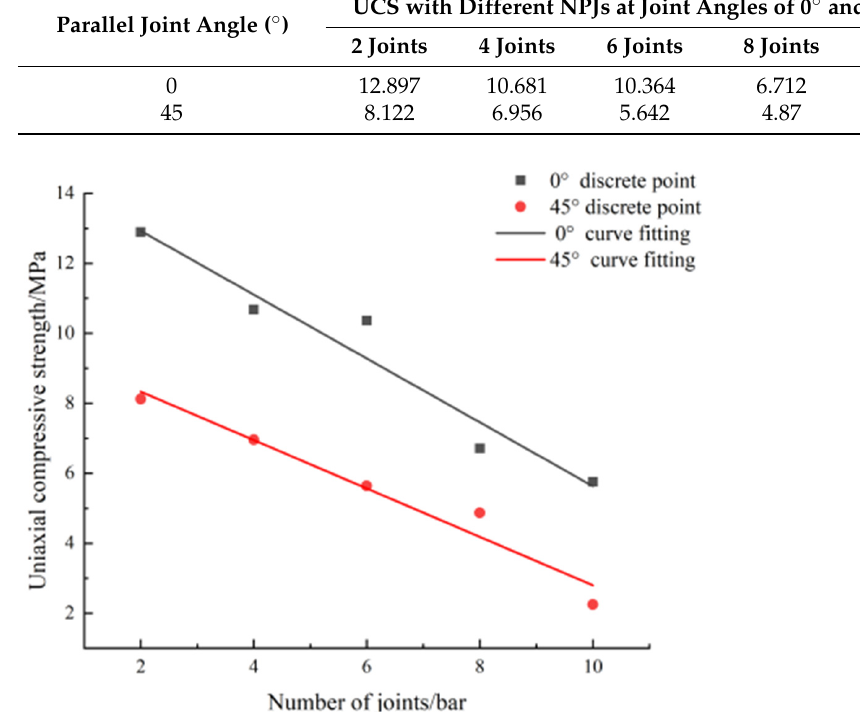
Figure 16. Fitting curve of UCS with different NPJs when parallel joint angles are 0 ◦ and 45 ◦